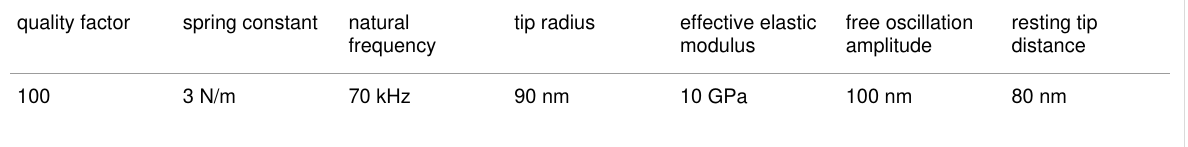
Table 2: Simulation parameters for the spring–mass–dashpot AFM model in the intermittent-contact imaging regime. For simplicity, no attractive forces are considered. The repulsive interaction is modelled using the Hertzian contact model. The simulation parameters are selected to resemble those of day-to-day intermittent contact AFM experiments. The cantilever parameters are the same as given in Table 1.